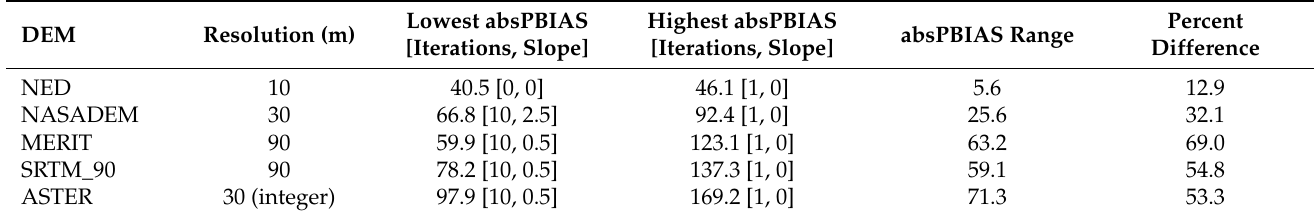
Figure 2. Average absPBIAS in FwDET2.1 water depth calculations for combination of number of iterations [0–10] (top x-axis) and slope threshold [0–2.5] (bottom x-axis) using NED, NASADEM, MERIT, ASTER, and SRTM_90 DEMs. Table 3. Summary of the optimization runs (Figure 2). Slope and absPBIAS are in %.